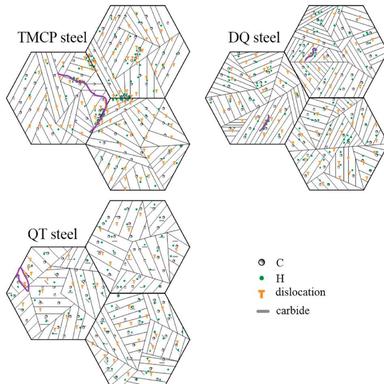
SCC mechanism diagram of Ni advanced steels with different microstructures.